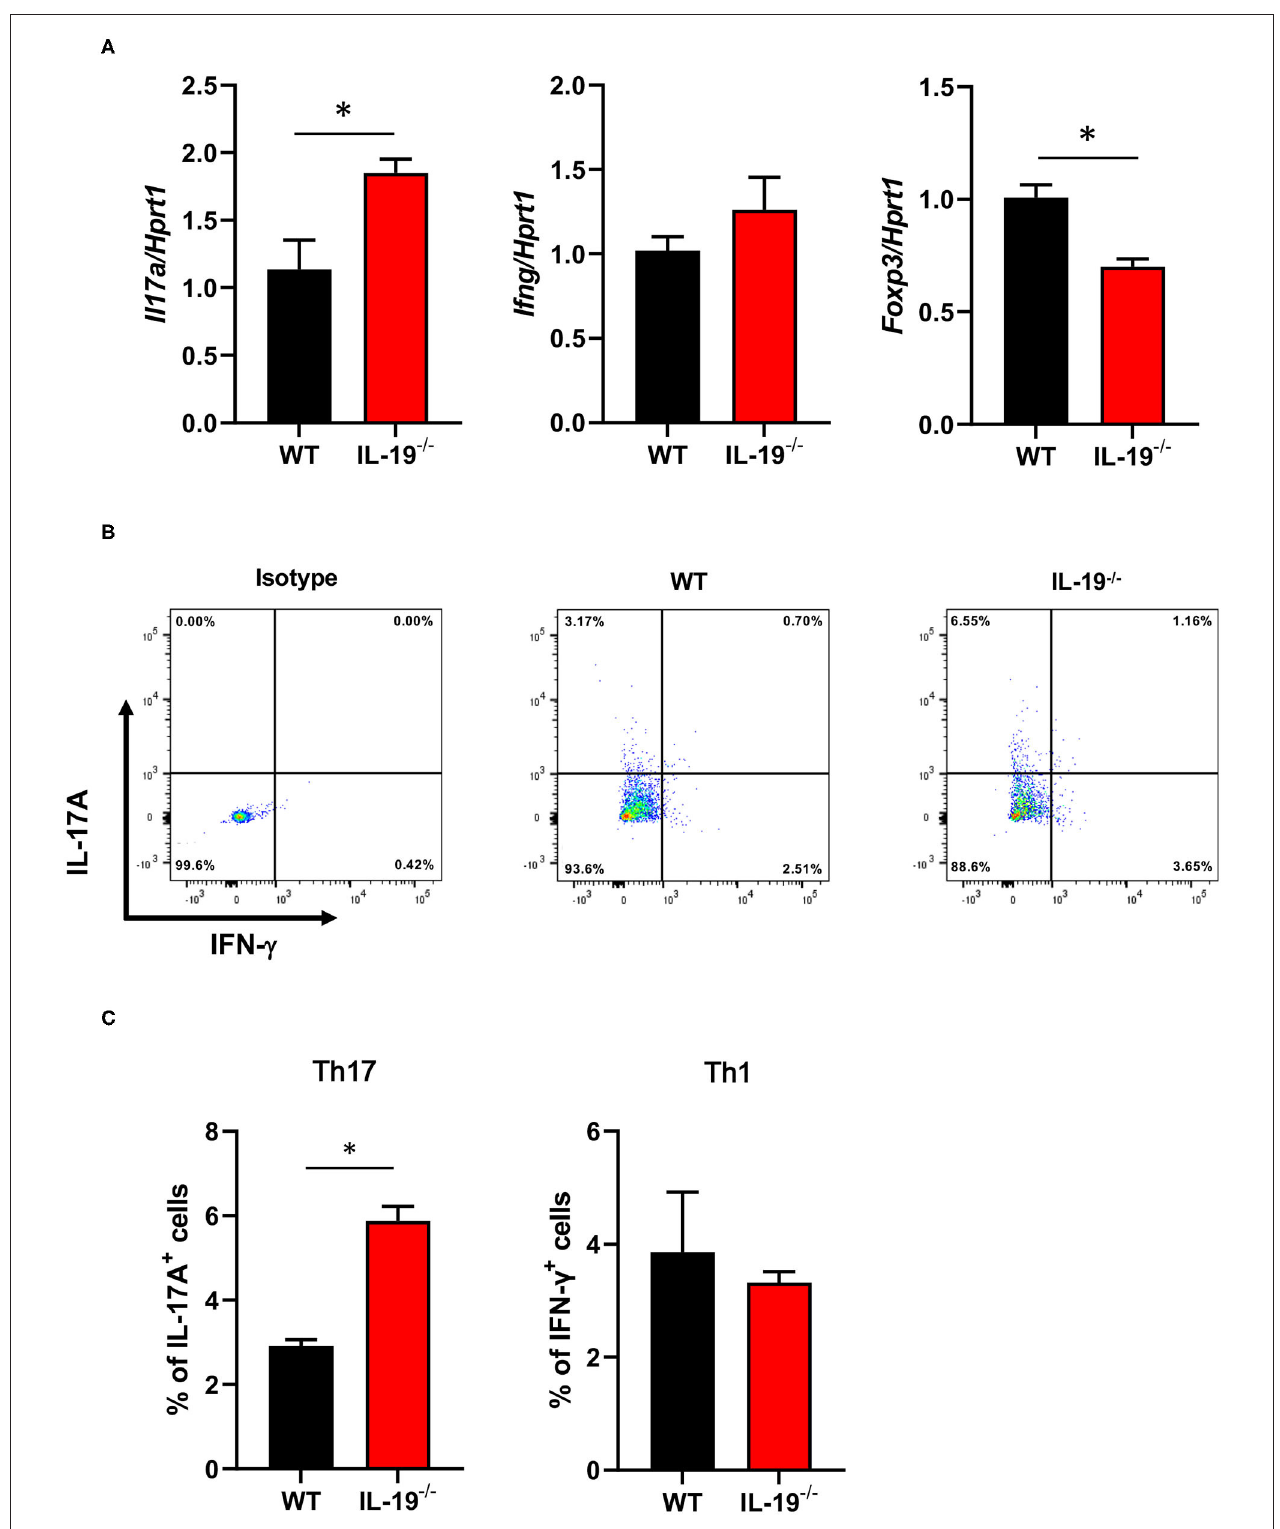
FIGURE 3 | IL-19 deficiency expands the Th17 cell population. (A) qPCR data for levels of mRNAs encoding IL-17A, IFN- γ , and FoxP3 in splenic CD4 + T cells (B) Representative flow cytometric data for IL-17 and IFN- γ -producing CD4 + T cells in the spleens of EAE mice. (C) Percentage of IL-17 and IFN- γ -producing CD4 + T cells in the spleens of EAE mice. Cells were isolated from WT and IL-19 − / − EAE mice on 7 days after immunization and stimulated with MOG peptide for 3 days in vitro . Statistical significance was analyzed using Student’s t -test. Data represent means ± SEM ( n = 3). * p < 0.05.